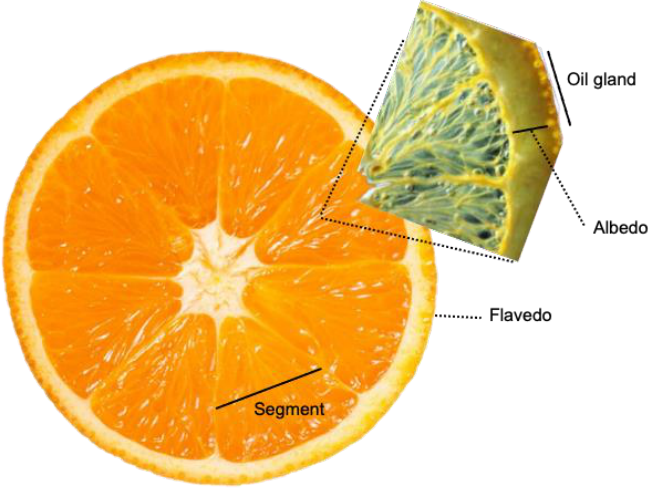
Figure 6. Localization of oil gland in orange peel